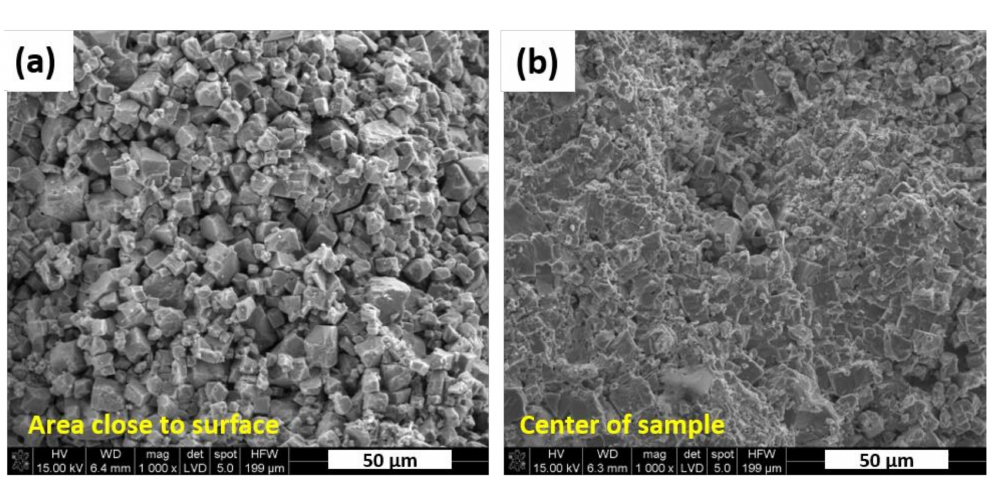
Figure 5. Fracture morphology recorded from two areas in the N5E1 sample: ( a ) the area close to surface of sample covered by h–BN layer during hot pressing (coarse grains), ( b ) the area in the center of the sample (fine grains); SE mode in low vacuum.